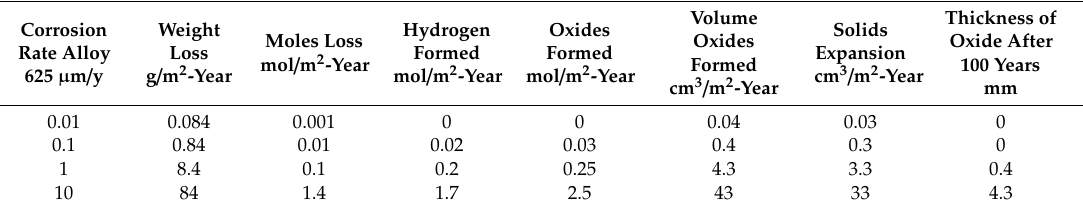
Table 2. E ff ect of corrosion rate of Alloy 625 on metal loss, hydrogen generation, oxide formation, and solids expansion.